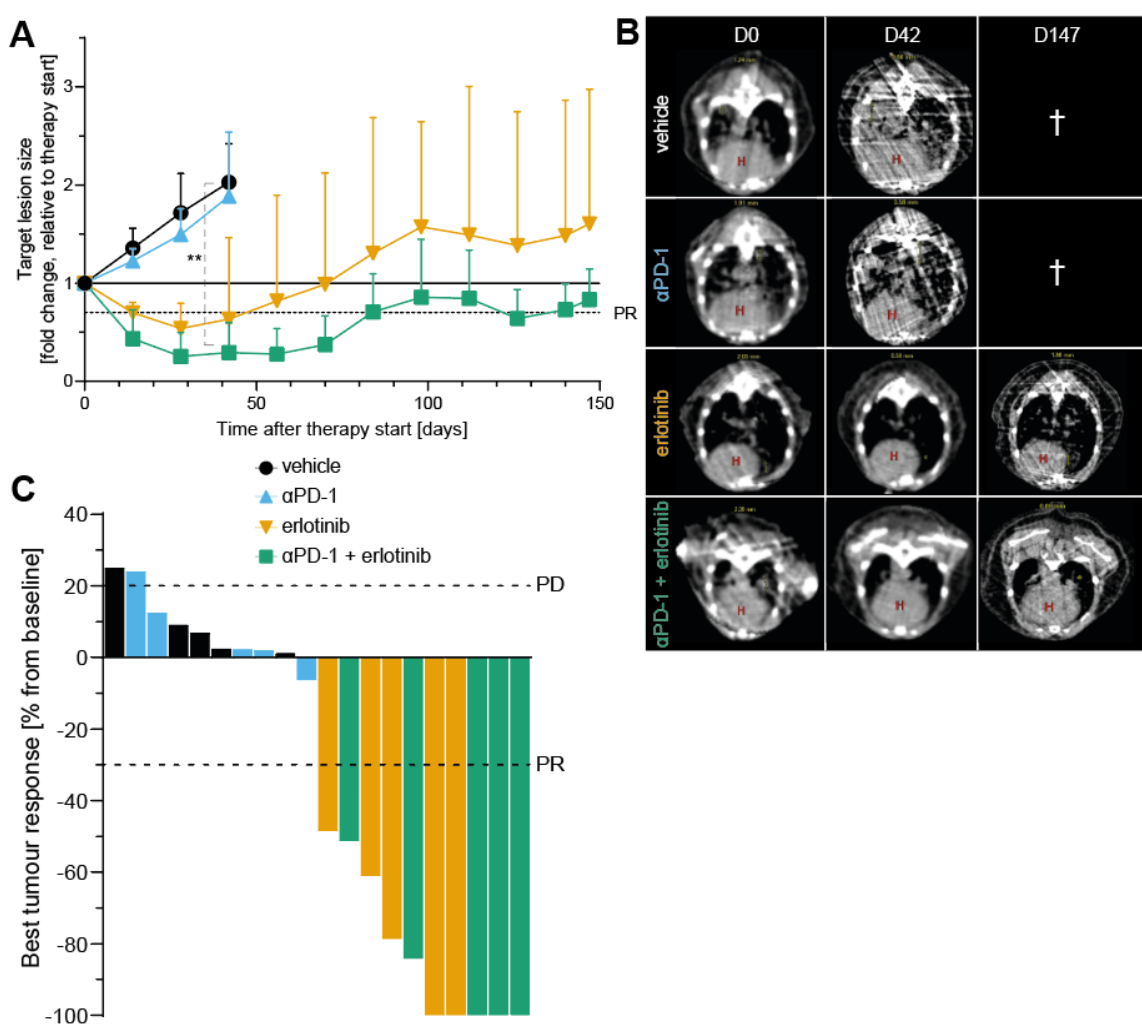
Figure 5. Simultaneous EGFR inhibition and ICB indicate slower tumour growth and improved antitumour response over EGFR inhibition alone in EGFR-driven NSCLC model. ( A ) Mean fold change of EGFR-driven target lesion growth over time in indicated treatment groups. Data are shown as the mean with SD; the statistical test used was Student’s t -test of individual groups at the endpoint of vehicle and aPD − 1 groups (day 42; statistically significant changes are indicated as follows: ** p < 0.01). ( B ) Representative µ CT images taken prior to therapy start (D0) and on days 42 (D42) and 147 (D147) after therapy start of EGFR L858R -driven mice; the red H indicates the heart; † indicates that no mice from treatment group reached the indicated time point. ( C ) Best response to therapy from beginning of treatment (baseline) for individual mice. ( A , C ) PR, partial response; PD, progressive